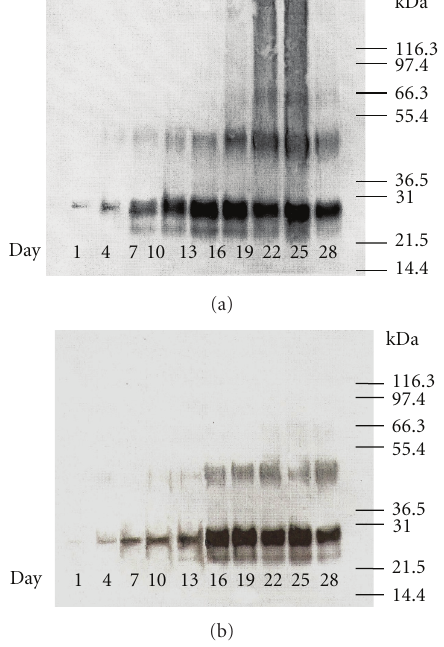
Figure 2: Western blot analysis of human VEGF 165 b produced by (a) encapsulated HEK293 VEGF 165 b producing cells and (b) nonencapsulated HEK293 VEGF 165 b producing cells.